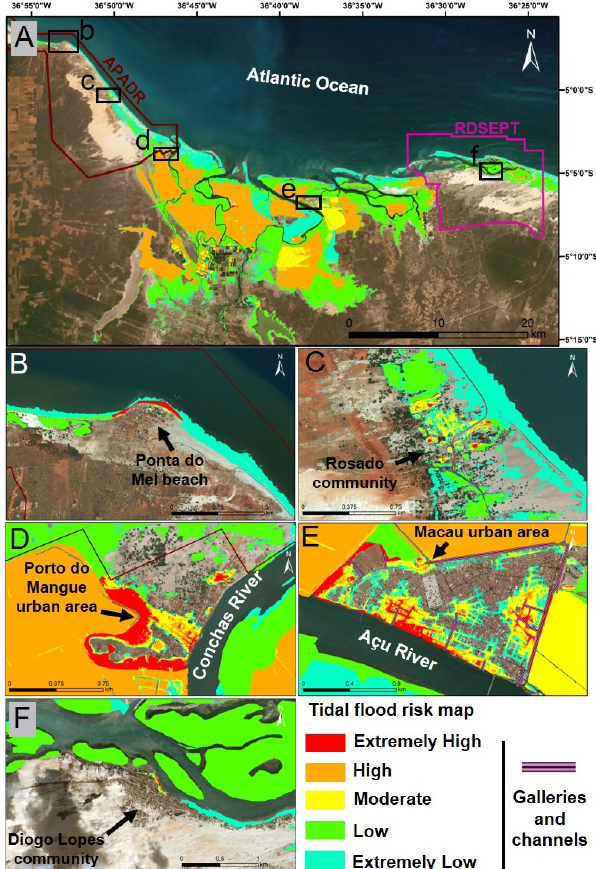
Figure 11. Tidal flood risk map for Piranhas–Açu estuary: (a) view of entire study area; (b) Ponta do Mel community; (c) Rosado com- munity; (d) Porto do Mangue urban area; (e) Macau urban area; and (f) Diogo Lopes community. Basemap from ArcGIS Online: ©